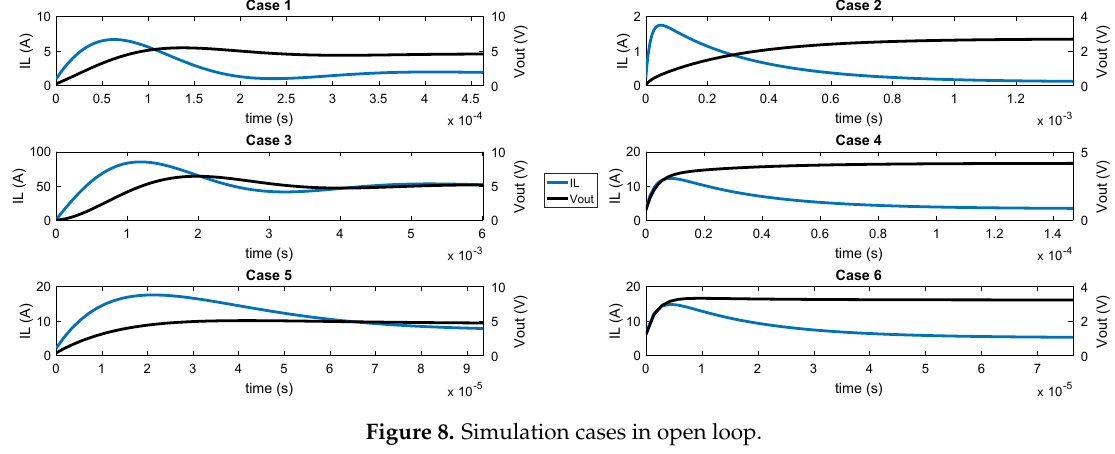
Figure 8. Simulation cases in open loop.